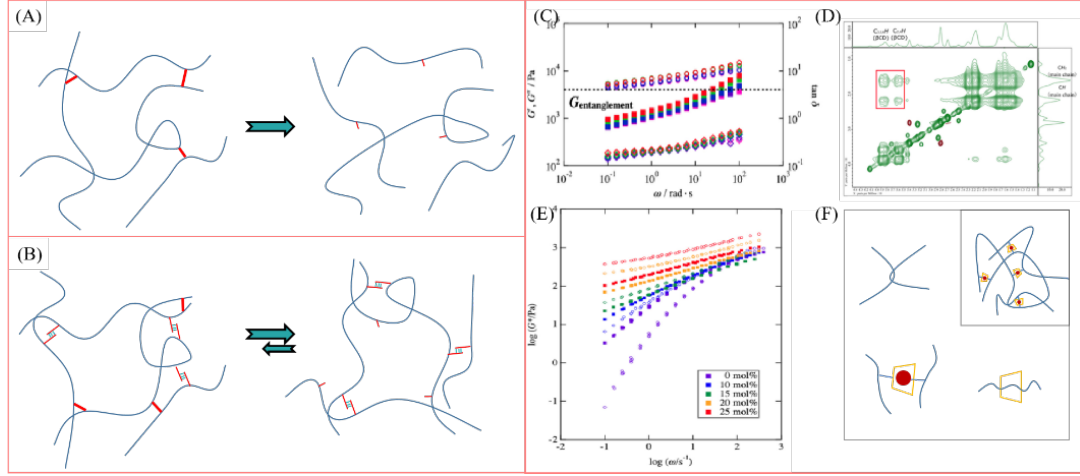
Figure 5. ( A , B ) Covalent polymer networks and supramolecular polymer networks (the red thick line represents covalent cross-linking, while the red thin line represents non-covalent cross-linking). ( C ) G′, G″, and tan δ of host–guest gels containing various concentrations of host molecules. The dashed line represents the plateau value of the entangled polyacrylamide solution with the same concentration [129]. ( D ) Two-dimensional (2D) NMR spectrum of the polyacrylamide solution containing β -CDs [25]. ( E ) Dynamic viscoelastic measurements of polyacrylamide containing only host molecules [25]. ( F ) Crosslinking mode of HPAM containing cyclodextrin adamantane complex.